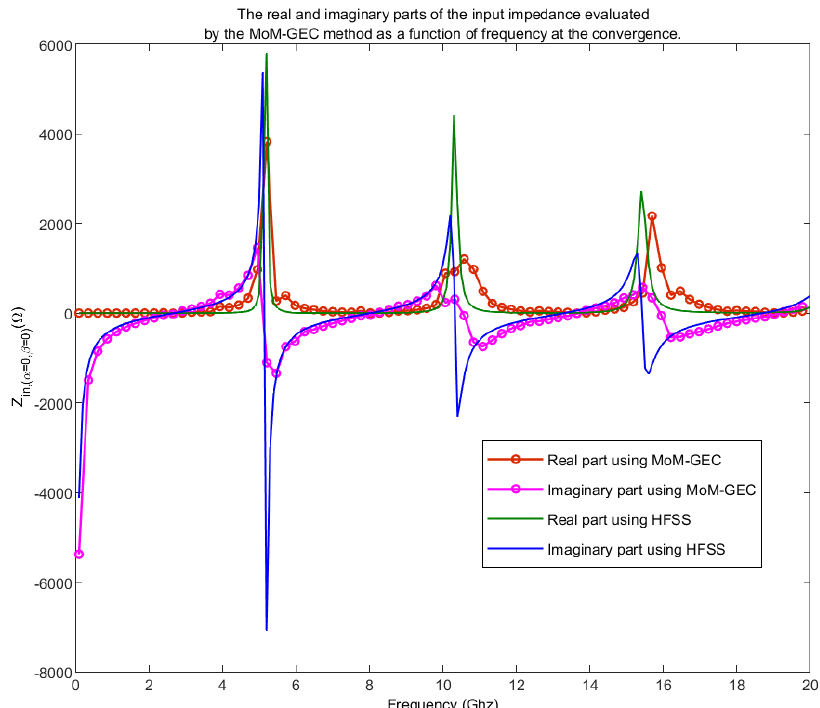
Figure 4. Input impedance seen at the source of one of four antennas given by the MoM GEC method and the HFSS tool (Validation) [18].